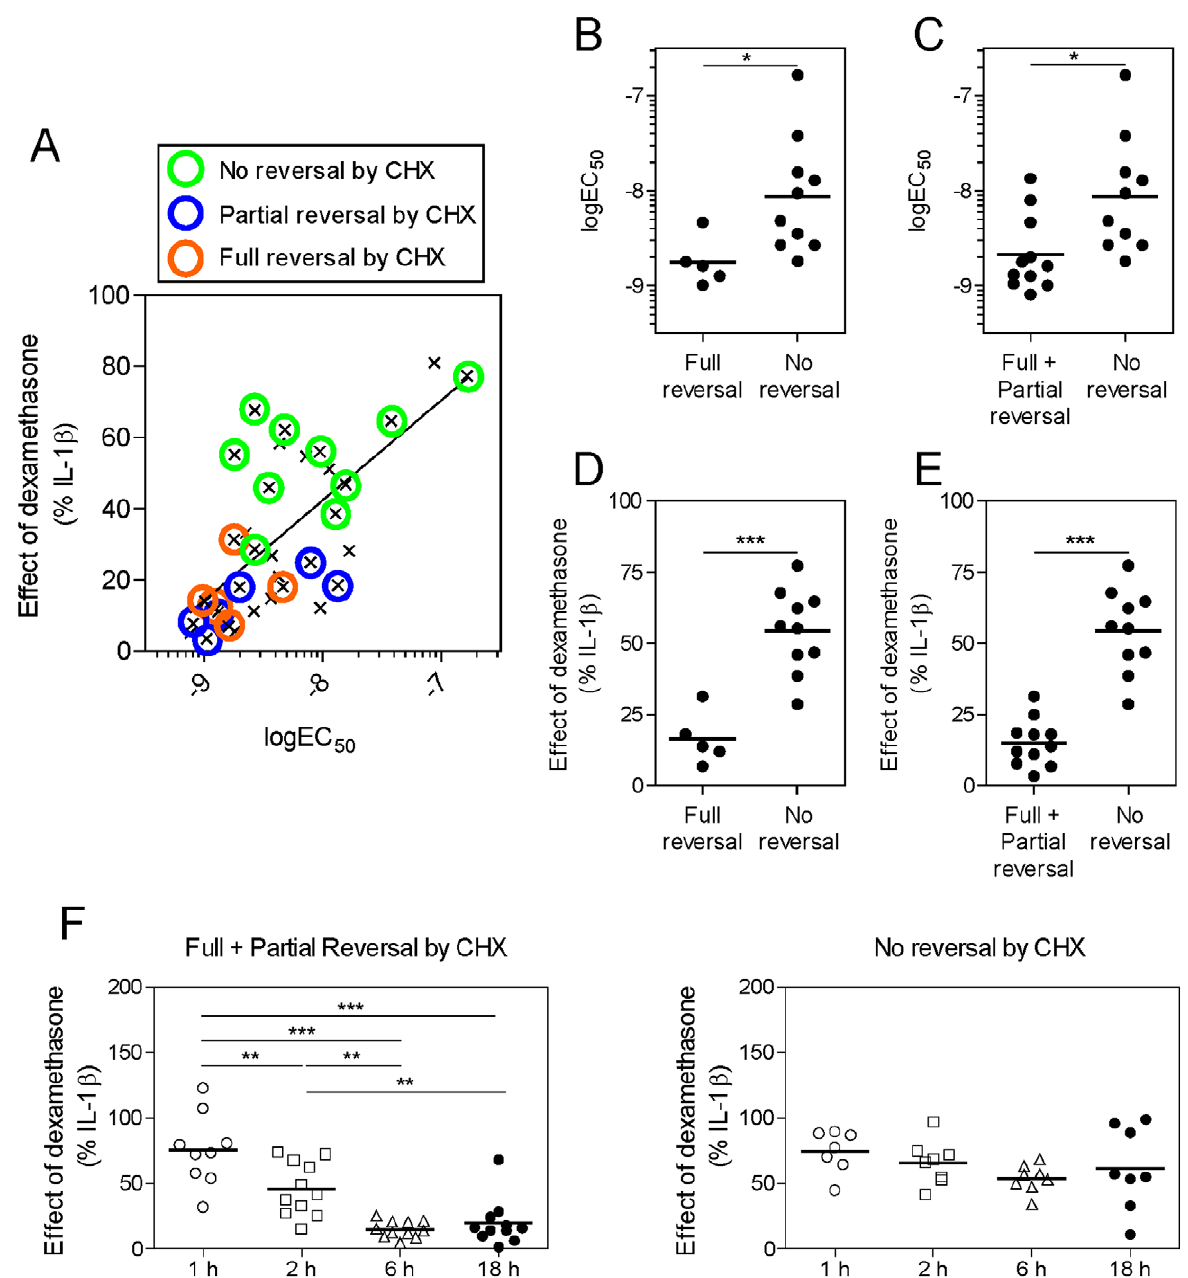
Figure 6. Relationship between the sensitivity and potency of repression by dexamethasone and the reversal by cycloheximide in A549 cells. A. Data showing the effect of 1 m M dexamethasone (as % IL-1 b ) plotted against the EC 50 for repression of each target mRNA by dexamethasone (i.e. Figure 2D), were overlaid with the effect of cycloheximide (CHX) on that repression (as shown in Figure 5). The logEC 50 values for repression by dexamethasone of mRNAs showing: B, full reversal, or; C, full + partial reversal of this repression by cycloheximide were compared with the logEC 50 values for mRNAs showing no reversal of dexamethasone-dependent repression by cycloheximide. Likewise, the effect of dexamethasone at 1 m M, expressed as a percentage of IL-1 b , was compared for mRNAs showing: D, full reversal, or; E, full + partial reversal of this repression by cycloheximide were compared with mRNAs showing no reversal of dexamethasone-dependent repression by cycloheximide. Statistical analyses were performed by unpaired t-test. * P , 0.05, *** P , 0.001. F. Data showing the effect of 1 m M dexamethasone at 1, 2, 6 and 18 h (from Figure 1) are plotted for the group of genes showing reversal of repression by cycloheximide (left graph) and the group of genes showing no reversal (right graph). Statistical analysis was performed using ANOVA with a Bonferroni post-test and is indicated: *, P , 0.05; **, P , 0.01; ***, P , 0.001. doi:10.1371/journal.pone.0053936.g006 IL-1 b (at 6 h). The effects of dexamethasone, in the presence of expression (Figure S1 and Table S2). This finding is supported by IL-1 b , on these genes was highly variable, with a few genes real-time PCR data showing repression for 34 out of 39 IL-1 b - showing further enhanced expression, many genes showing little induced mRNAs. While the reversal of this dexamethasone- effect of dexamethasone and the majority revealing reduced dependent repression by both a GR antagonist, ORG34517, and